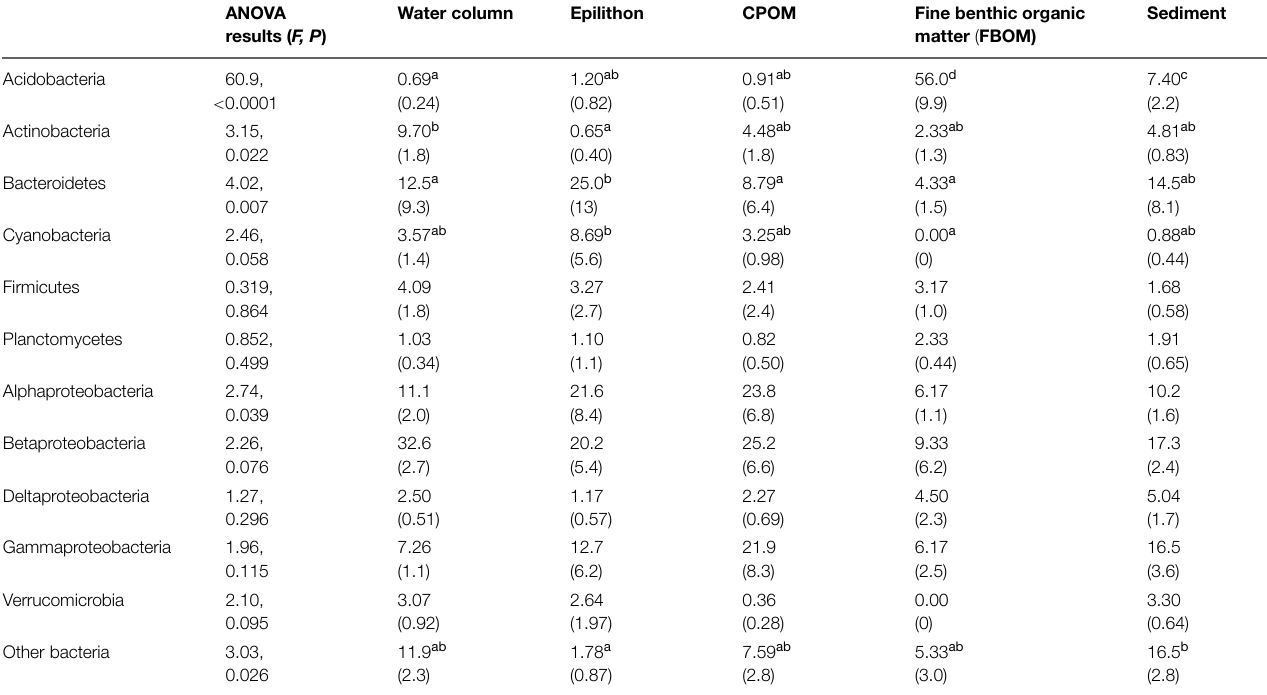
TABLE 2 | Relative abundance [%, (1 SE)] of bacterial phyla and subphyla (rows) in stream compartments (columns) including analysis of variance (ANOVA) results for among-compartment comparisons: omnibus results in first column, and significant multiple comparisons groups (Bonferonni post hoc test, α = 0.05) in lower case superscripts